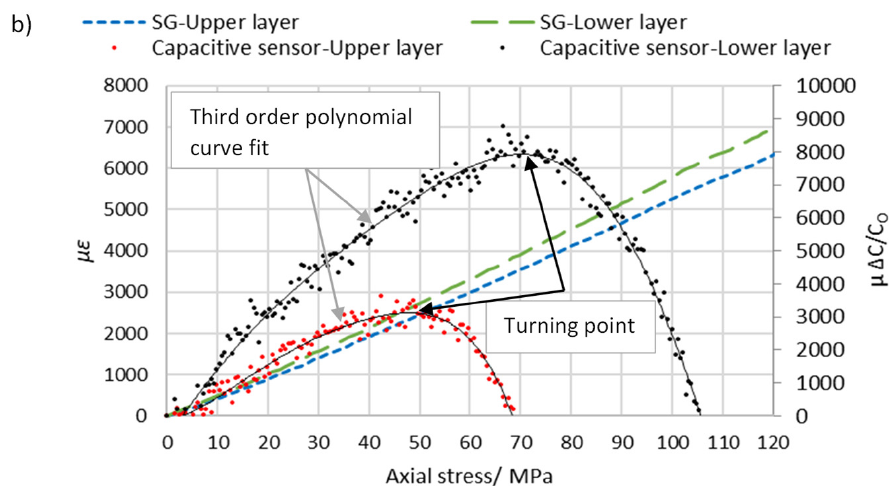
Figure 7. Graph of relative change in capacitance and nominal strain against the axial stress for the type A configuration, ( a ) sample A − 1 pulled to breaking point; and the inset in graph ( a ) shows an enlarged view where the ranges of the x - and y -axes were limited to 100 MPa and 6000 µ ε . ( b ) Experimental result for sample A − 2 where ranges of the x- and y -axes were limited to 120 MPa and 8000 µ ε .